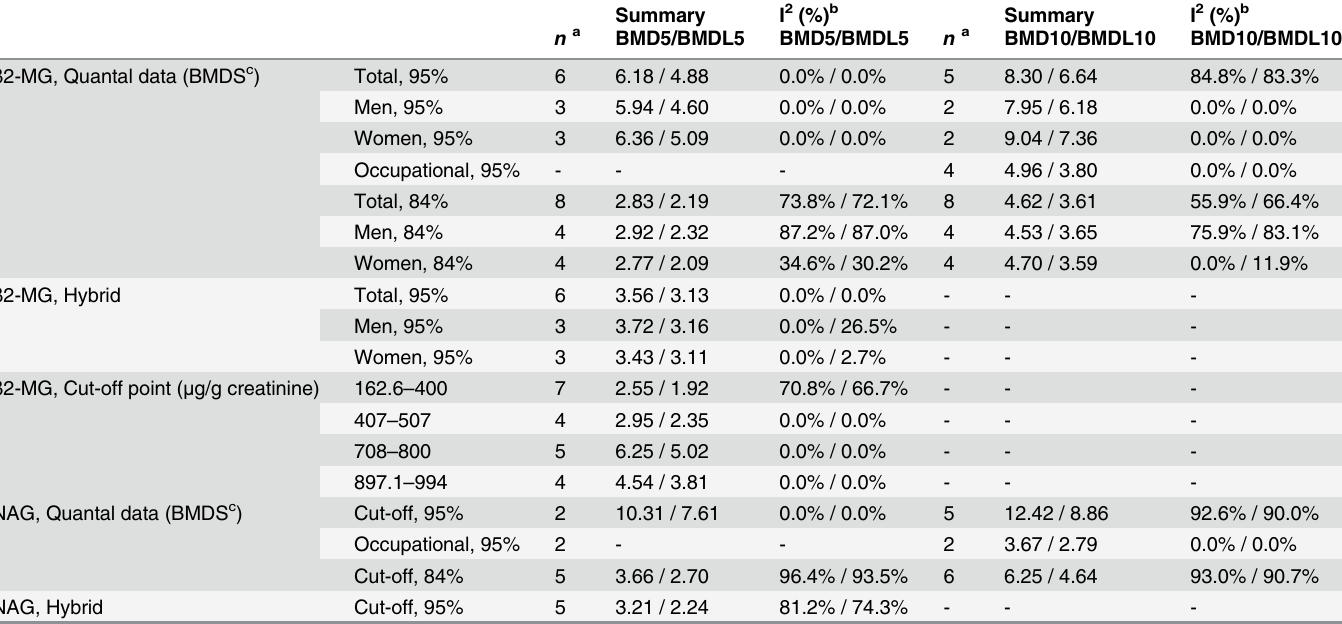
Table 4. Pooled estimates of BMD derived from urinary cadmium and β 2-MG and NAG.